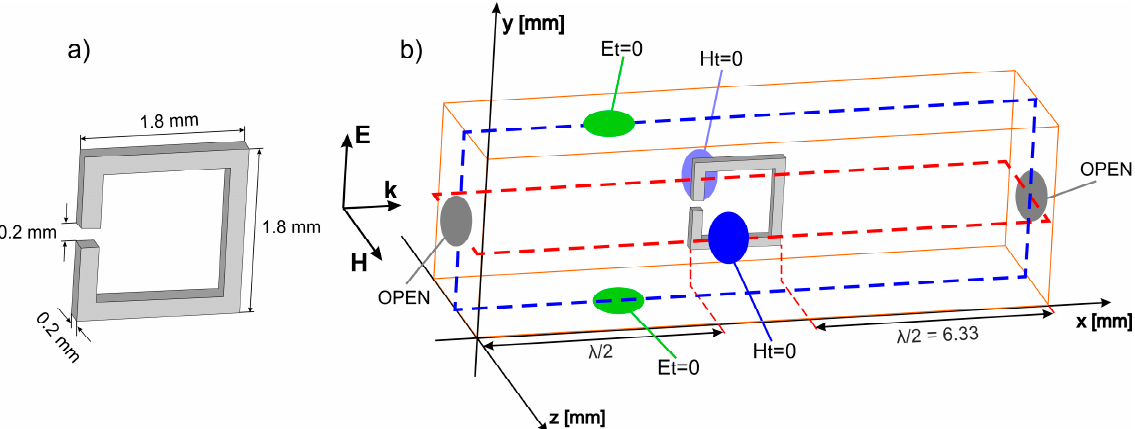
Figure 1. The geometry of the SRR resonator ( a ) and the computation area (marked in orange lines) with the boundary conditions ( b ). The electric field strength vector E of the incident electromagnetic wave is directed in the +y direction. The magnetic strength vector H is directed in the +z direction.